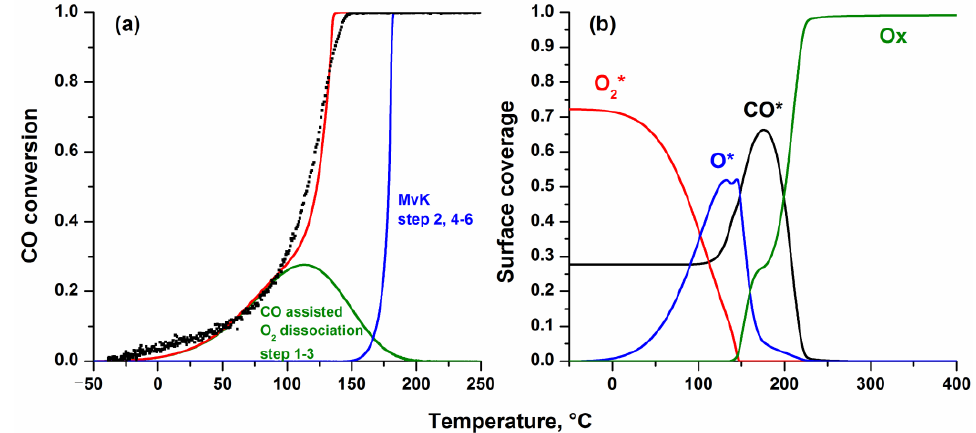
Figure 10. Temperature dependencies of ( a ) CO conversion and ( b ) coverages of the platinum by adsorbed species during the TPR-CO + O 2 on the Pt-C catalyst at the ratio O 2 /CO = 5 (inlet O 2 concentration—5 vol.%). The dotted curves correspond to the experimental data, and the solid lines are results of the modelling. The estimated rate constants are k 6 = 6.75 × 10 5 s − 1 · bar − 1 , k − 6 = 10 13 e − 26 RT s − 1 , k 7 = 0.0037 s − 1 · bar − 1 , k 8 = 1.5 × 10 2 e − 7 RT s − 1 , k 9 = 10 13 e − 19 RT s − 1 , k 10 = 10 13 e − 29 RT s − 1 , and k 11 = 75 s − 1 · bar − 1 . The values of the parameters characterizing the experimental conditions are presented in Section 3, Material and